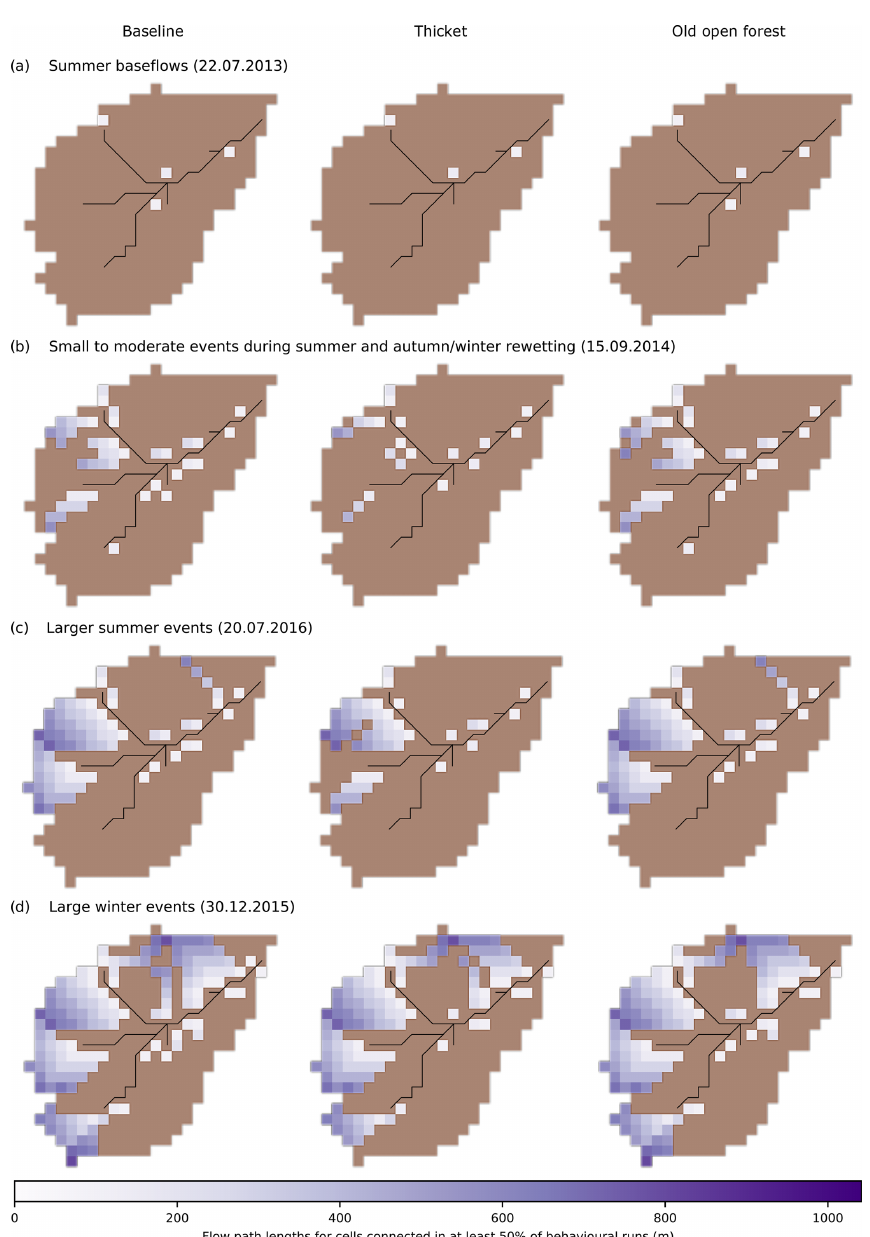
Figure 9. Spatial patterns of hydrological connectivity simulated in at least 50% of behavioural model runs for dates representative of (a) summer baseflows, (b) small to moderate events during summer and autumn/winter rewetting, (c) larger summer events and (d) large winter events. Disconnected cells are shown in